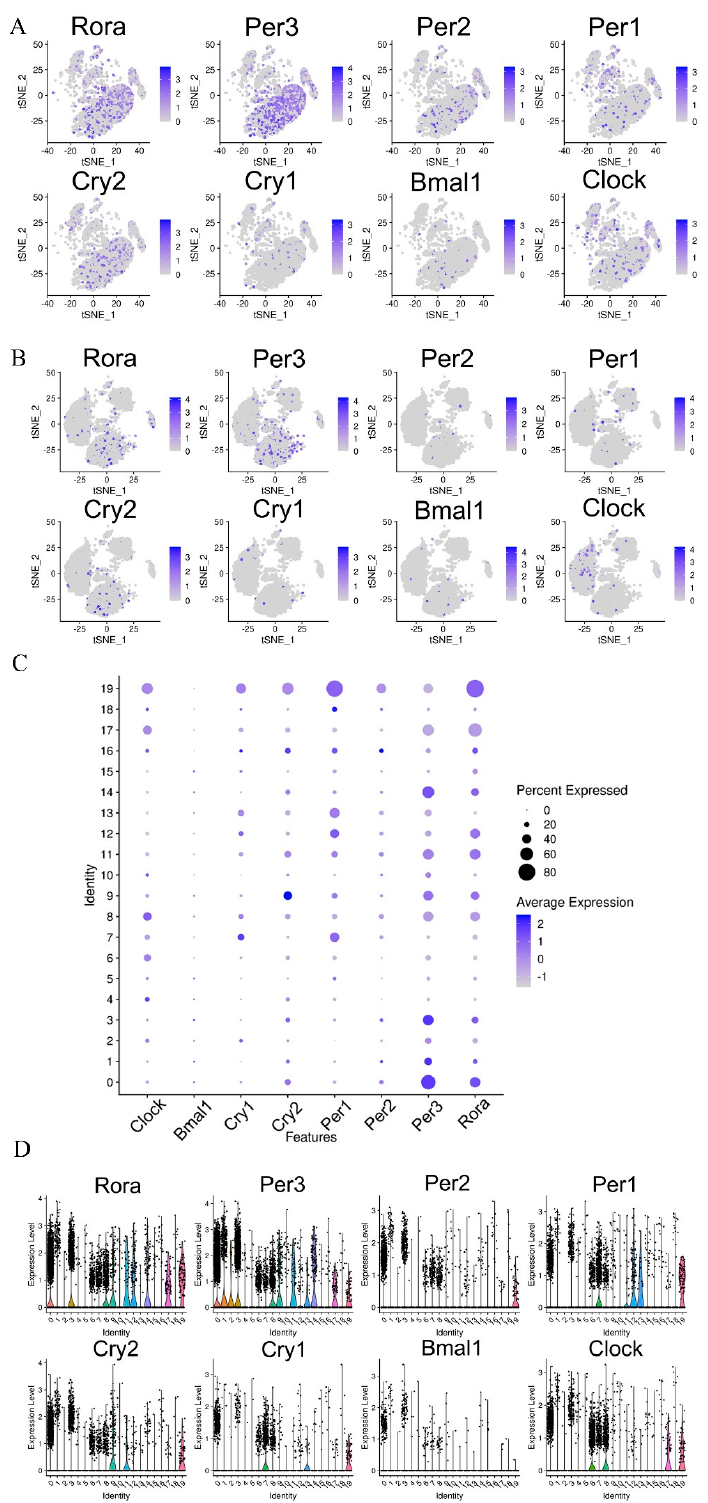
Figure 5. Effect of CPFs on the expression of circadian clock genes in the hypothalamus: t-SNE map of the expression of rhythm genes in the hypothalamus in the CPF group ( A ) and CD group ( B ). ( C ) Dot plots of circadian rhythm gene expression levels in different clusters of the CPF group. ( D ) Violin plot of the expression of circadian rhythm genes in the main cell types of the CPF